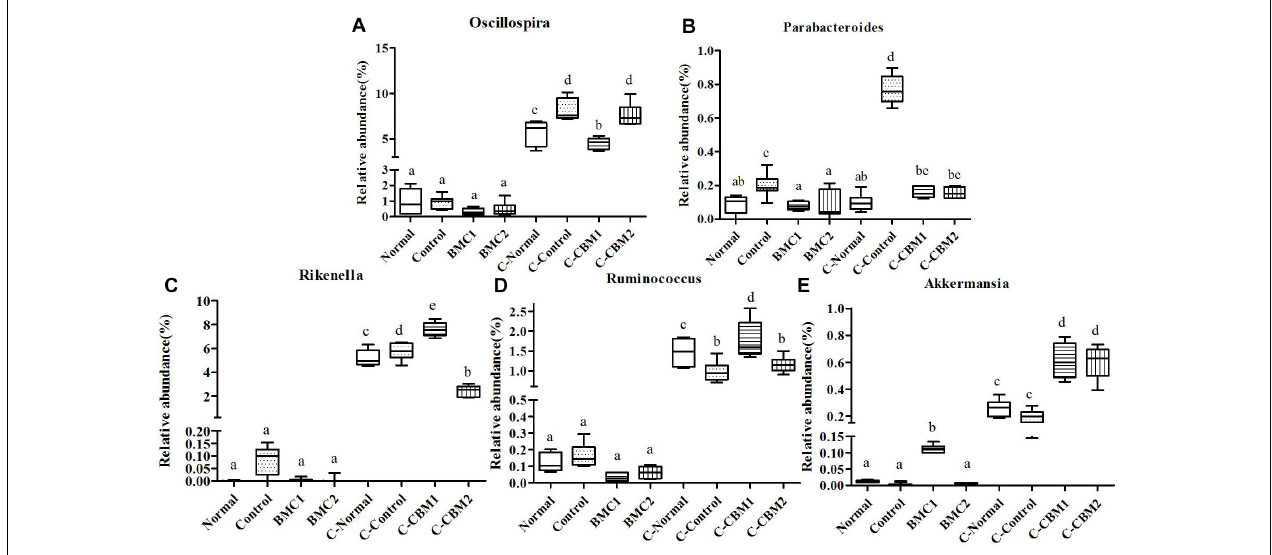
FIGURE 11 | The genus-level comparison of fecal samples and caecum content samples. (A) Oscillospira , (B) Parabacteroides , (C) Rikenella , (D) Ruminococcus , and (E) Akkermansia .